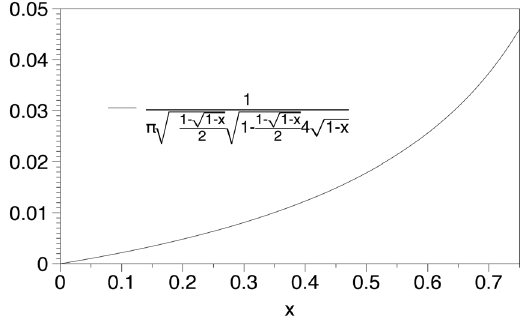
Figure 11. Integrand in the last integral of Eq.